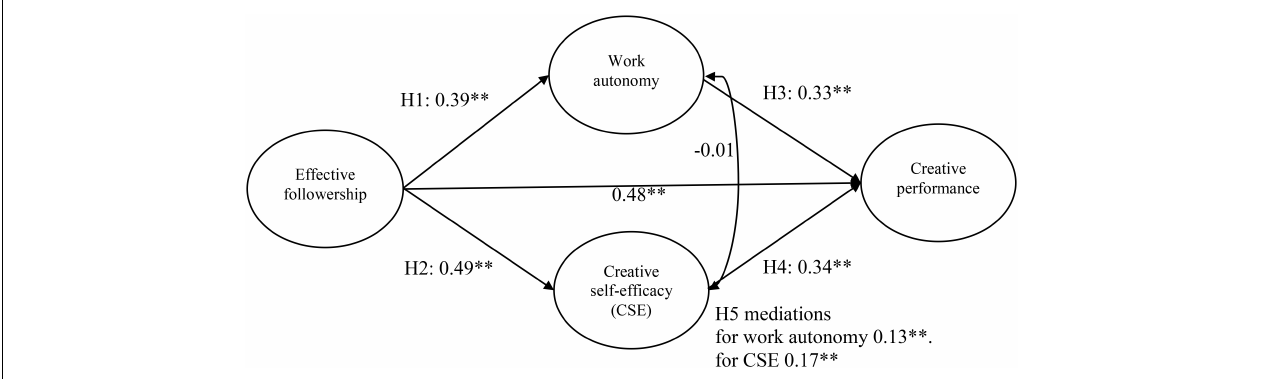
FIGURE 1 | Model of the results of this study. The coefficients of the mediating results used H1(0.39)*H3(0.33) and H2(0.49)*H4(0.34); thus, CSE exhibited stronger indirect effects than work autonomy in the model. ∗∗ p <